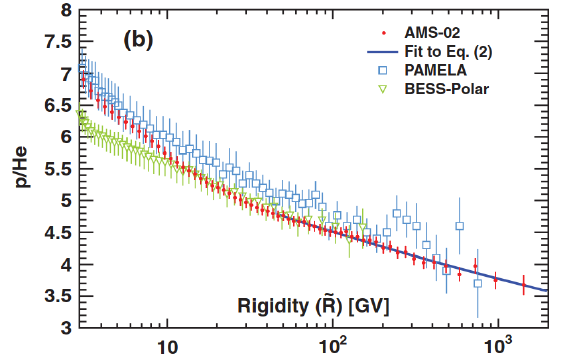
Figure 5. Proton over Helium ratio measured by di ff erent exper- iments [12].